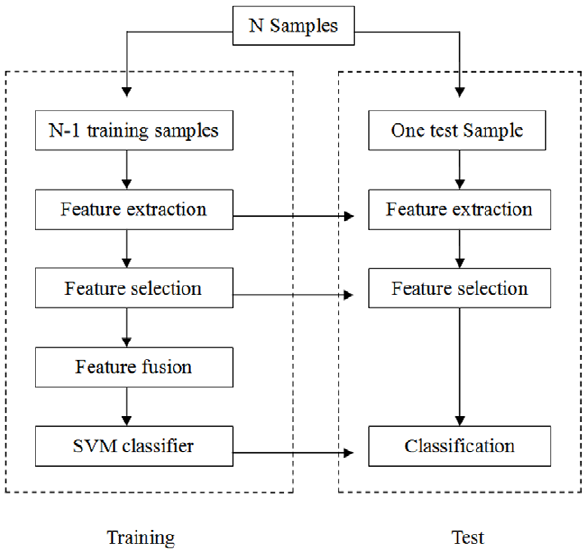
Figure 1. A flowchart of the multi-model method for classifi- cation.